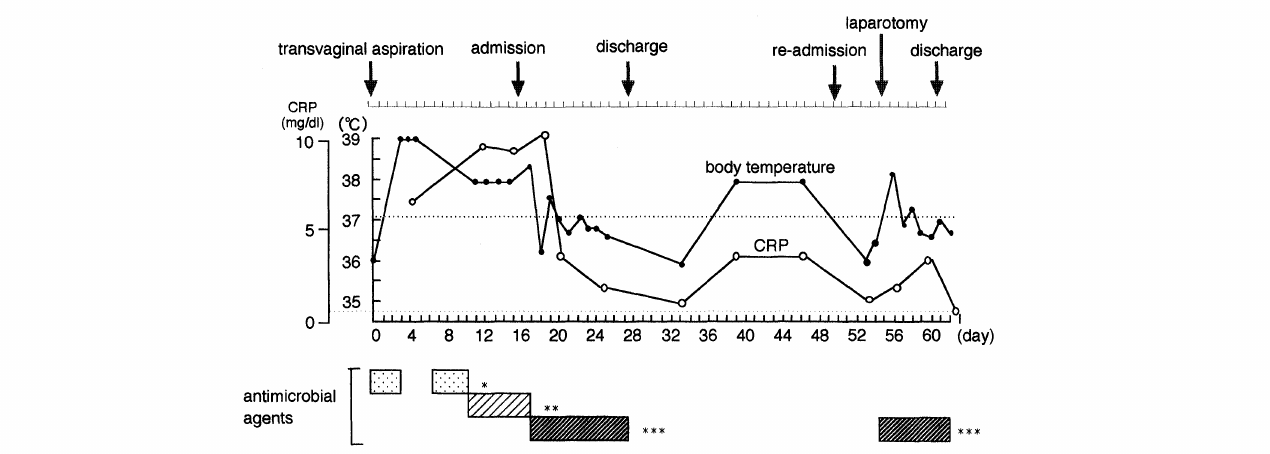
Fig. I. Clinical course of case I. * Cefteram pivoxil, 300 mg/day orally, three times a day. ** Cefminox, 2.0 g/day intravenously, two times per day. *** Panipenem/betamipron, 1.0 g/day intravenously, two times per